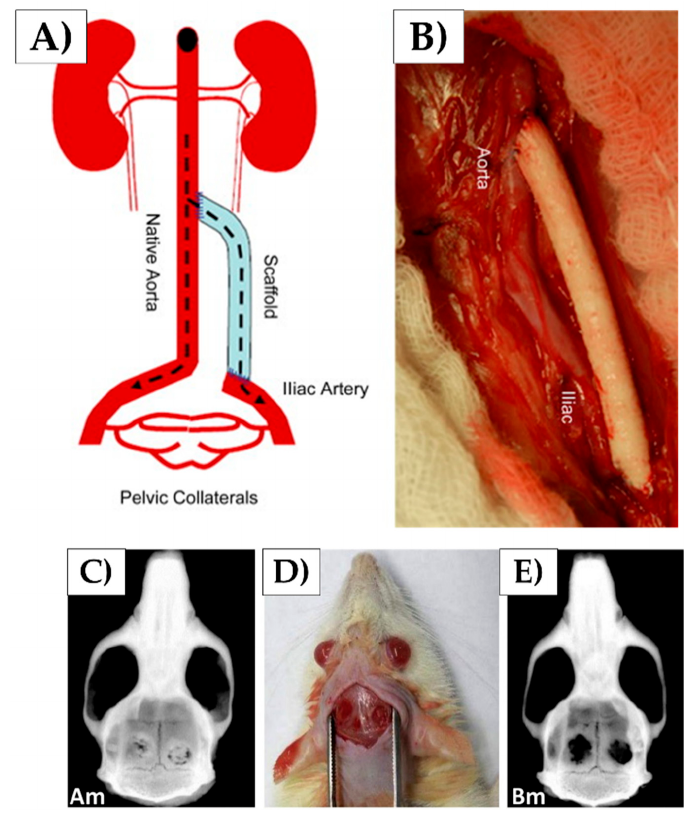
Figure 7. ( A , B ) Aortoiliac bypass using a PCL-collagen scaffold; ( C – E ) Effects of mulberry B. mori silk and non-mulberry A. mylitta silk on bone regeneration (reproduced with permission from